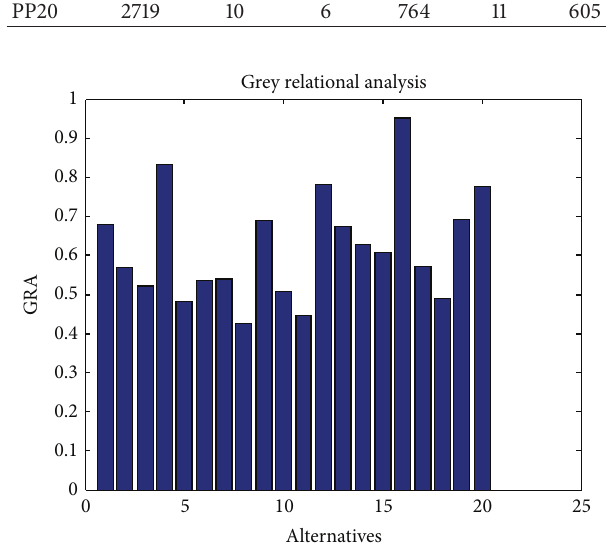
Figure 8: Results of grey relational